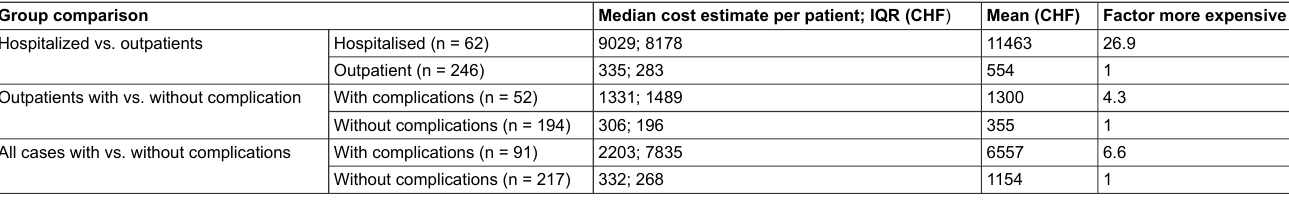
Table 3: Herpes zoster-related treatment costs. Group